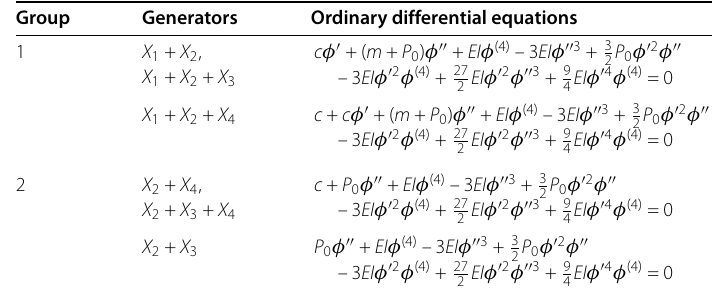
Table 2 The conditions for linearization in each case Group Nonlinear equations Conditions for linearization